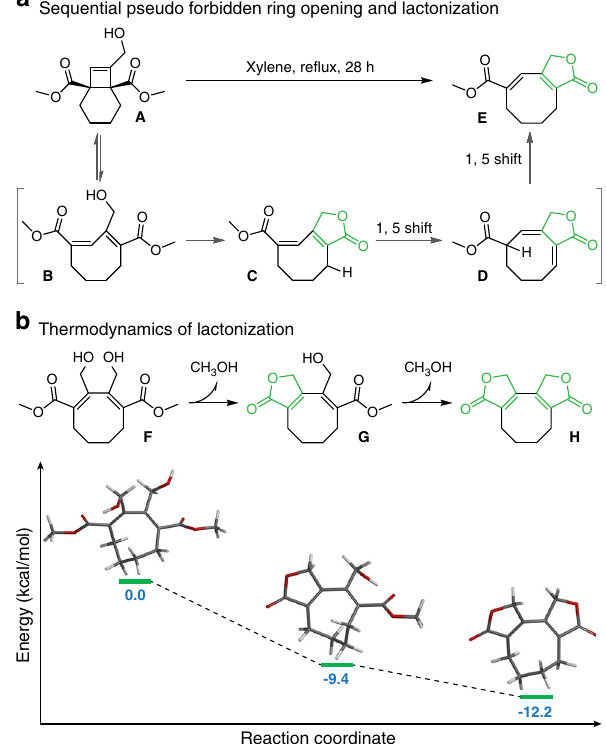
Fig. 2 Synthesis of pachylactone from a BCOE derivative and thermodynamics of lactonization. a Thermally induced sequential pseudo- forbidden ring opening and lactonization reported by Booker-Milburn and co-workers. b Computational study of the lactonization thermodynamics of a ring-opened BCOE species.